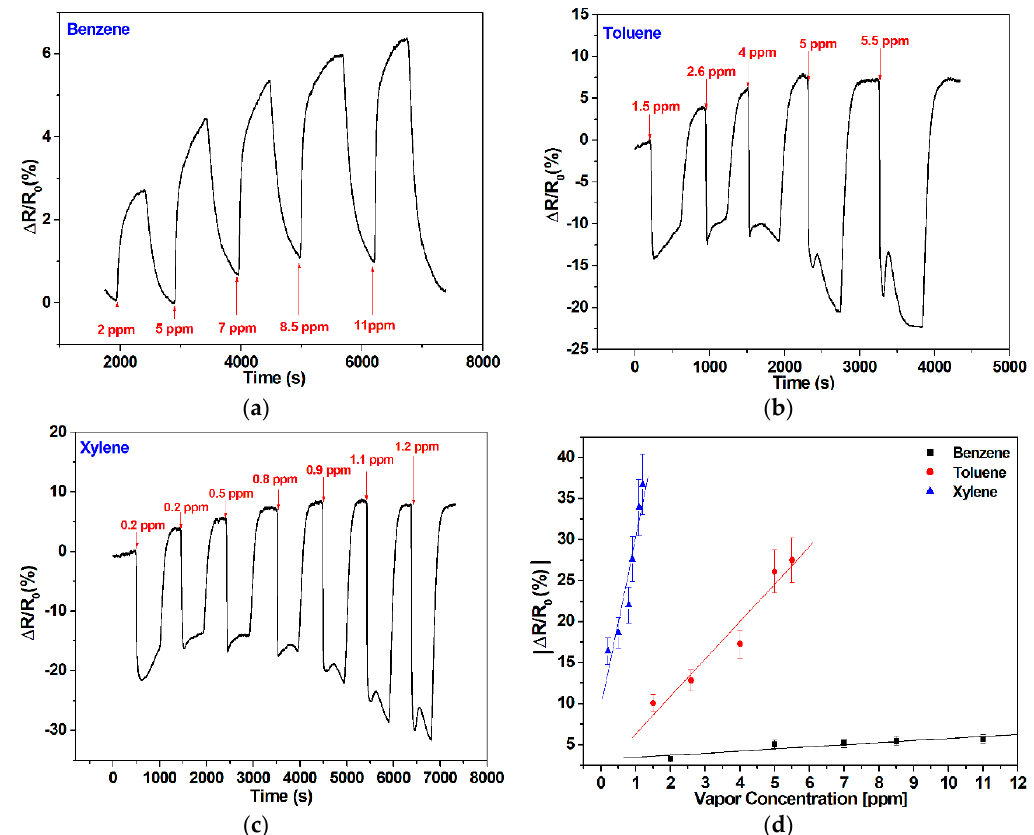
Figure 6. SnO 2 /graphene sensor responses for different concentrations of injected vapors of ( a ) benzene; ( b ) toluene; ( c ) xylene; and ( d ) associated calibration curves. A linear baseline correction was implemented for benzene exclusively (response shown in panel a), (see Supplementary Materials for more details).